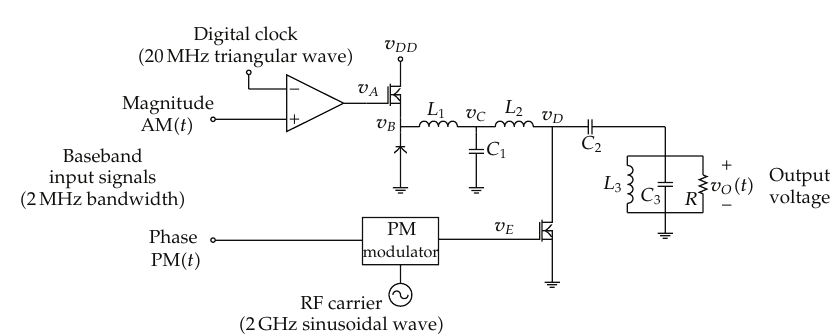
Figure 6: Simplified power amplifier schematic used in wireless polar transmitters (cid:8) 16 (cid:9)